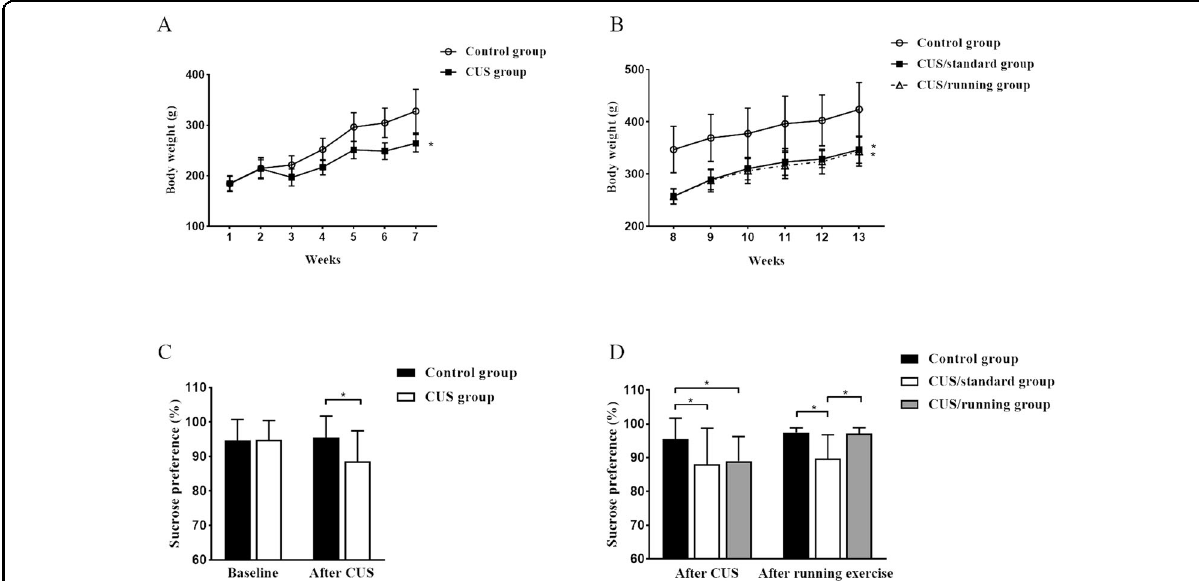
Fig. 3 The positive effects of running exercise on the depressive-like behaviors of CUS rats. A, B Body weight changes in rats at different stages (mean ± SD). A The body weights of the control group ( n = 23) and the CUS group ( n = 37) during the fi rst 7 weeks. B The body weights of the control group ( n = 23), the CUS/standard group ( n = 17), and the CUS/running group ( n = 20) during the last 6 weeks. C, D The sucrose preferences of rats at different stages (mean± SD). C The sucrose preferences of the control group ( n = 23) and the CUS group ( n = 37) at the end of CUS. D The sucrose preferences of the control group ( n = 23), the CUS/standard group ( n = 17), and the CUS/running group ( n = 20) at the end of the running exercise period. Asterisk indicates p < 0.05. CUS chronic unpredictable